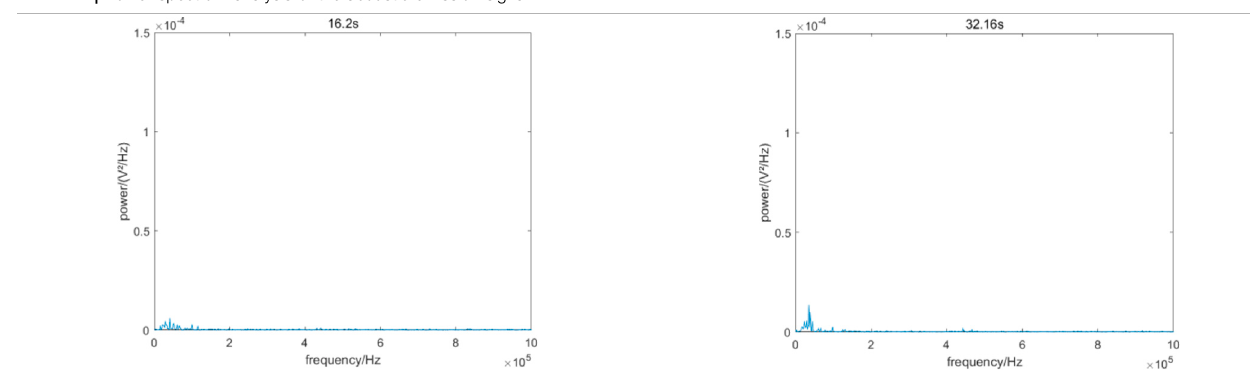
TABLE 1 | Power spectrum analysis of the acoustic emission signal.